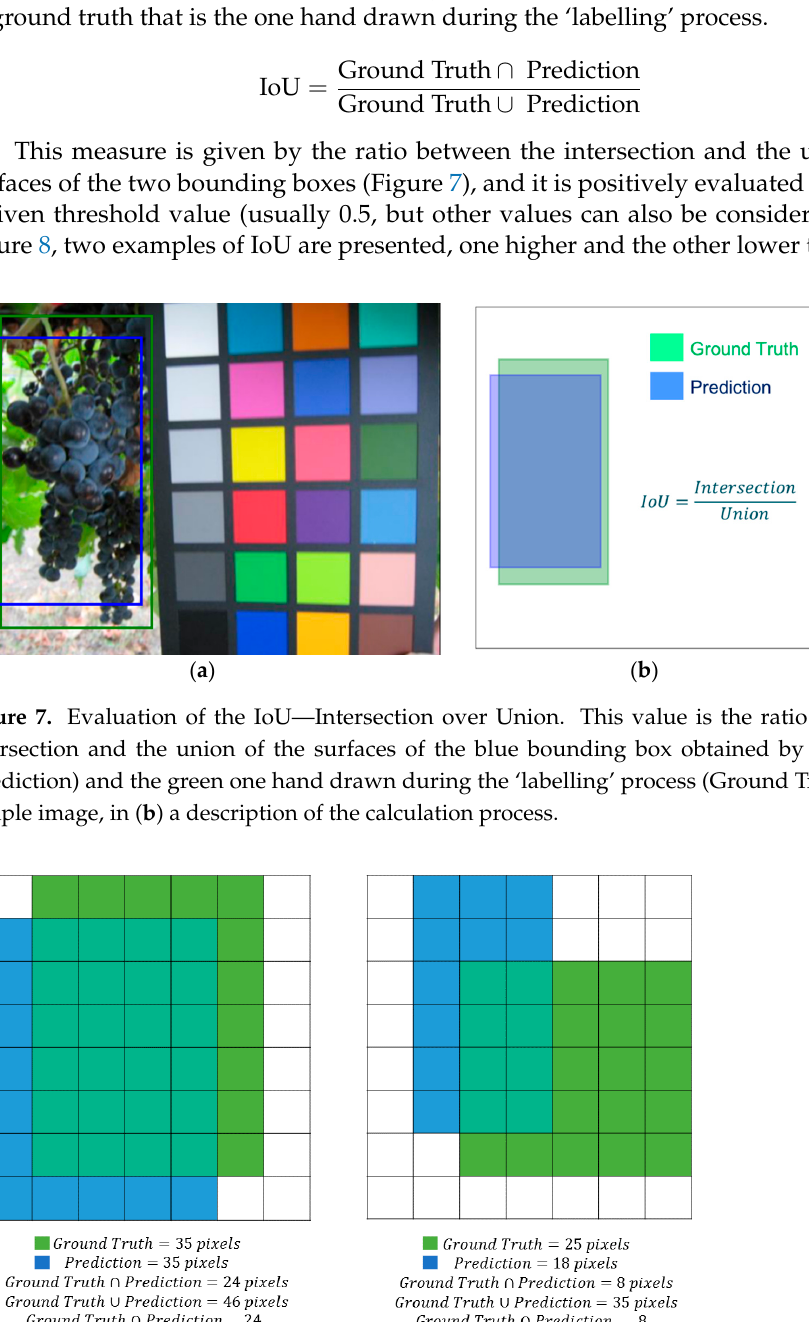
Figure 8. Two examples of IoU. In the example on the left the ratio between intersection and union of the ground truth and prediction bounding boxes is higher than 0.5 (0.52) while in the example on the right the ratio is lower (0.23).